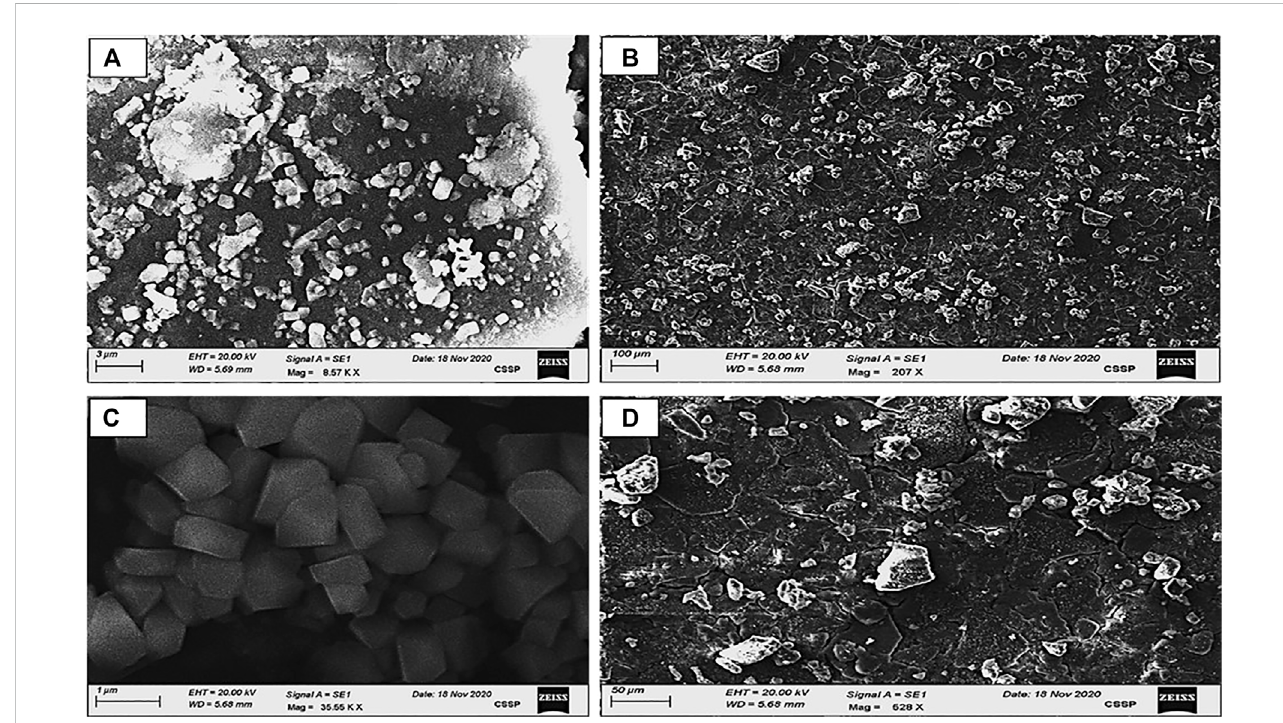
FIGURE 4 SEM images ofAgNP samples (A – D) ;calculated grainsize area: (A) = 40 nm, (B) = 50 nm, (C) =65 nm,and (D) = 79 nm obtained by 0.01 AgNO 3 derived from varied concentrations of the Piper cubeba extract at room temperature.